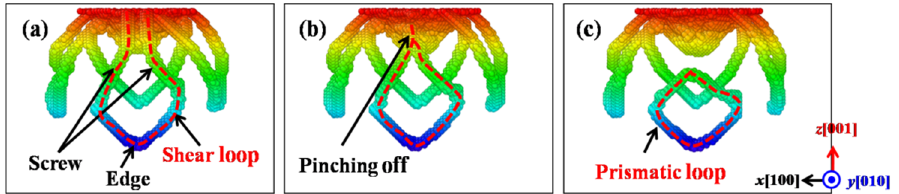
Figure 12. The formation process of prismatic loops based on the “lasso”-like mechanism observed under the indented (001) crystalline plane of ZnSe. Color scale from red to blue indicating depth from the indented plane. The dash line depicts the related shear loop for the formation of prismatic loops. ( a ) Screw and edge components in the shear loops. ( b ) Two screw components start to merge and prismatic loop has formed. ( c ) The formed prismatic loop has pinched off from the indentation region.